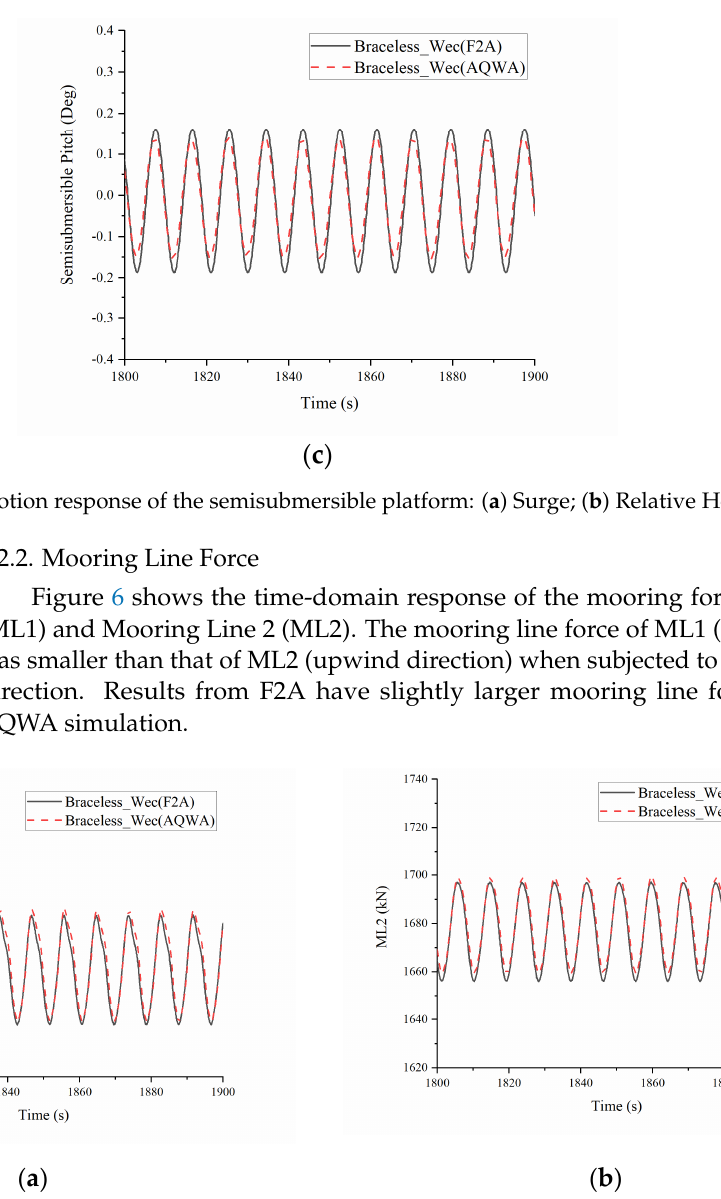
Figure 6. Mooring force of: ( a ) ML1; ( b ) ML2.